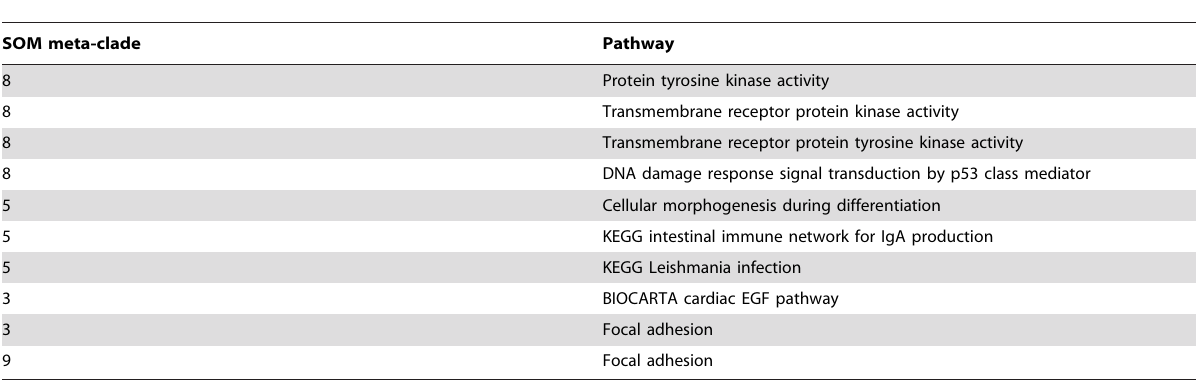
Table 2. Convergent pathways where the SOM meta-clades overlap with SOM clades found to be most positively correlated with the ASPL-TFE3 fusion transcript data.